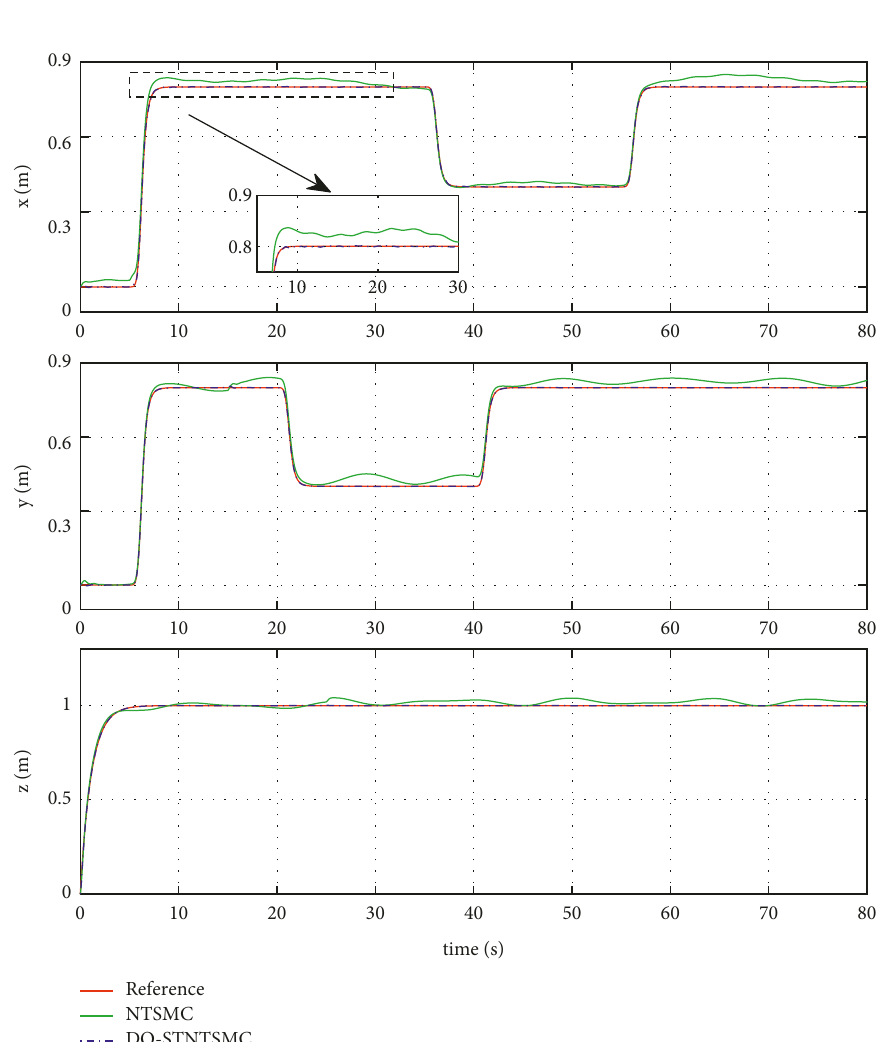
Figure 4: Quadrotor’s position ( x,y, z ) in the presence of complex